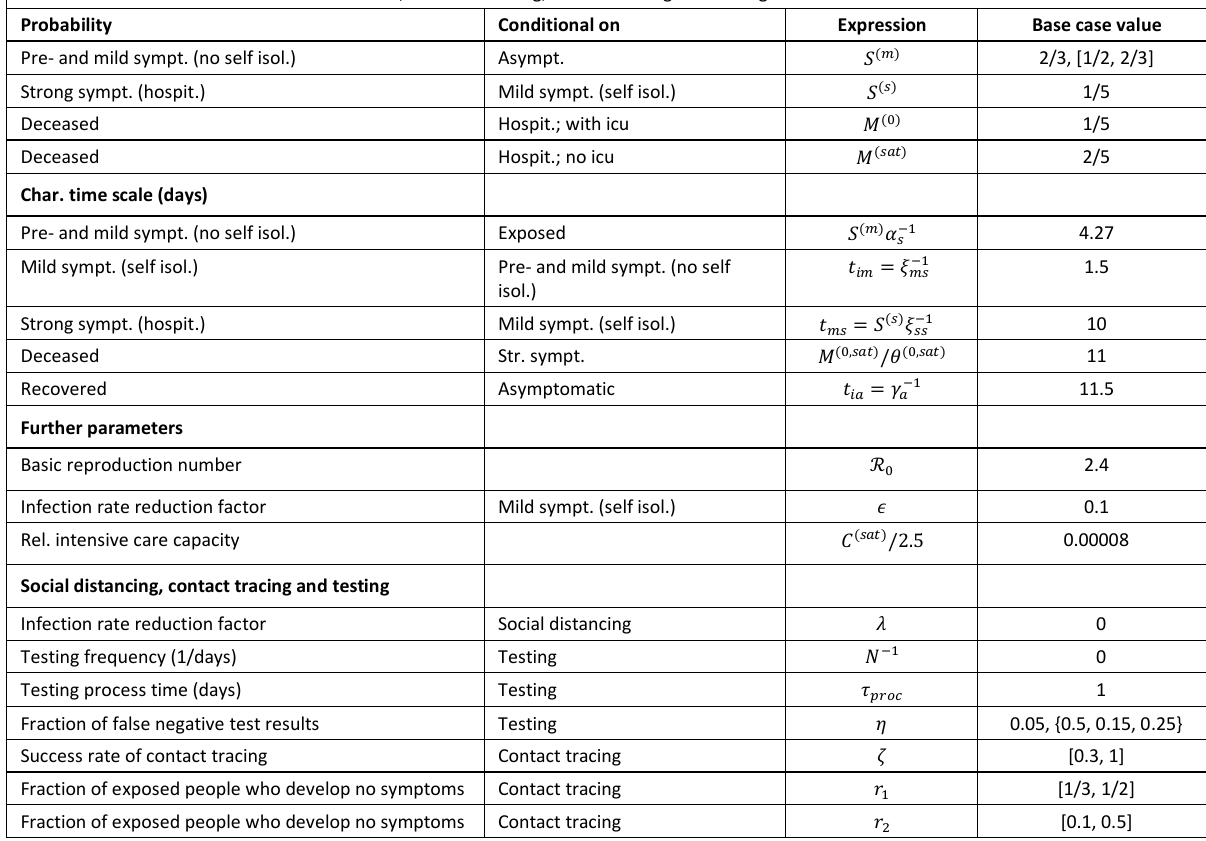
Table 2: Estimates made for the model closure, social distancing, contact tracing and testing. Probability Conditional on Expression Base case value Pre- and mild sympt. (no self isol.) Asympt. Strong sympt. (hospit.)